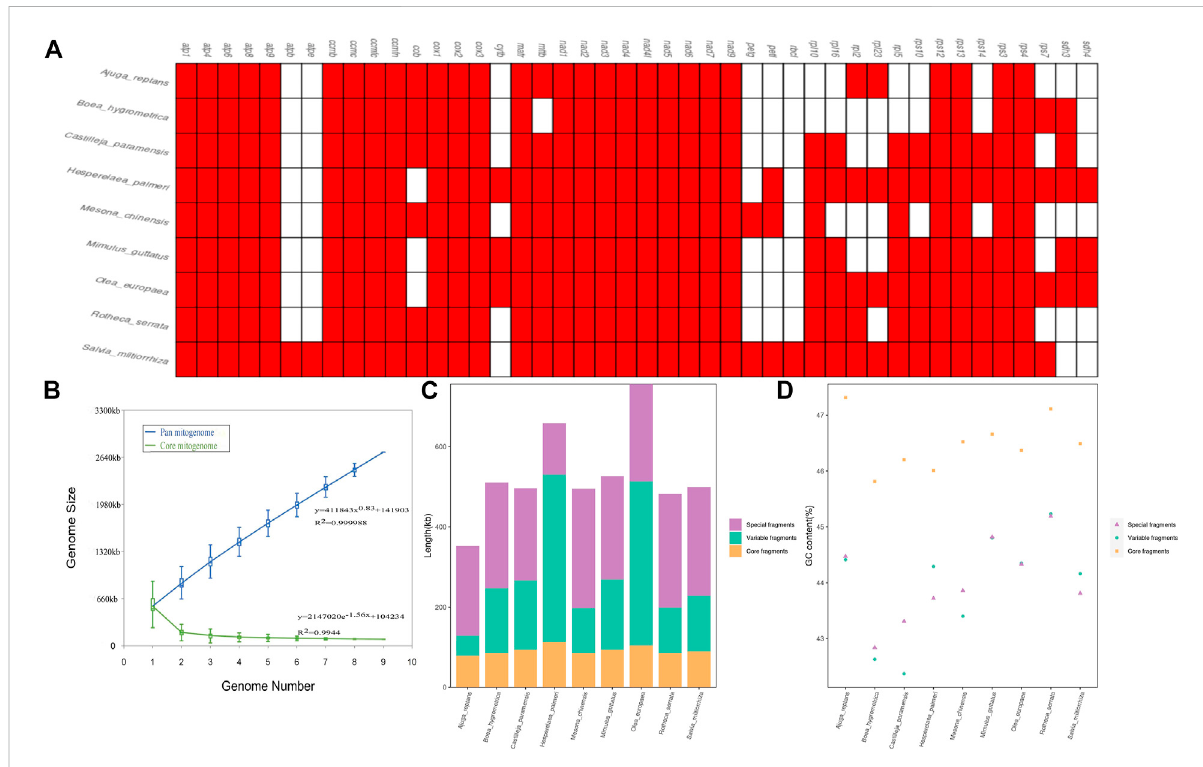
FIGURE 9 Variation in the gene content and constitution in Lamiaceae mitogenomes. (A) , The gene content of 9 Lamiaceae mitogenomes; (B) , Increase and decrease inthegenome size ofthepan mitogenome (blue)and core mitogenome (green); (C) ,The size variation ofdifferentcomponents inthe 9 Lamiaceae mitogenomes; (D) , The GC content variation of different components in the 9 Lamiaceae